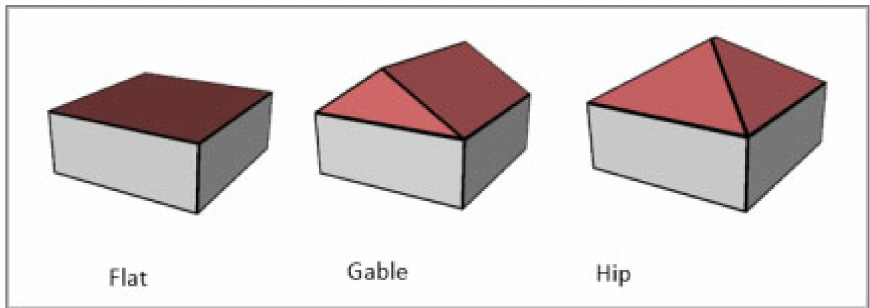
Figure 4. Different roof shapes with the same building footprint. Source: